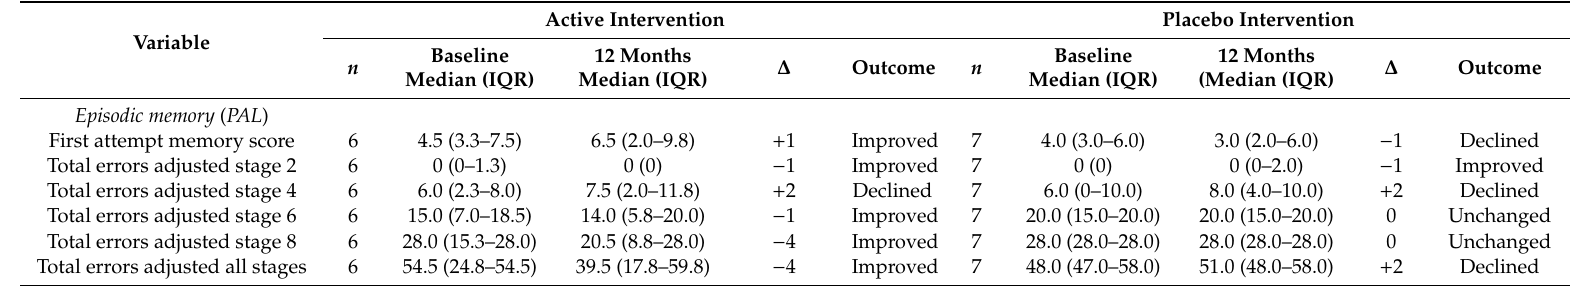
Table 6. Average change per subject in episodic memory, working memory and reaction time over 12 months between active and placebo intervention